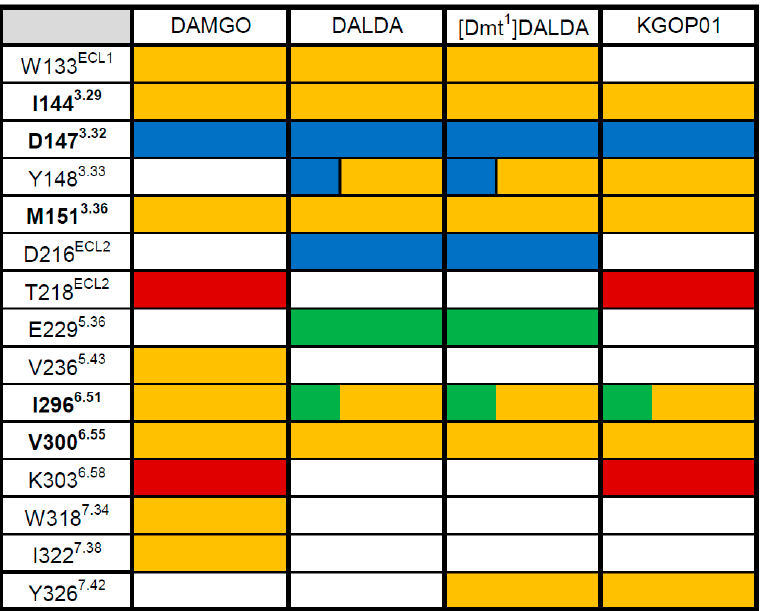
Figure 7. Ligand–MOR interaction pattern derived from molecular docking solutions of opioid peptides DAMGO, DALDA, [Dmt 1 ]DALDA, and KGOP01. Yellow fields indicate lipophilic contacts, red fields hydrogen bond acceptors, green fields hydrogen bond donors, and positively charged centers are shown as blue fields. White fields indicate the absence of an interaction with that residue. Residues which show the same type of interaction for all morphinan ligands are marked in bold.